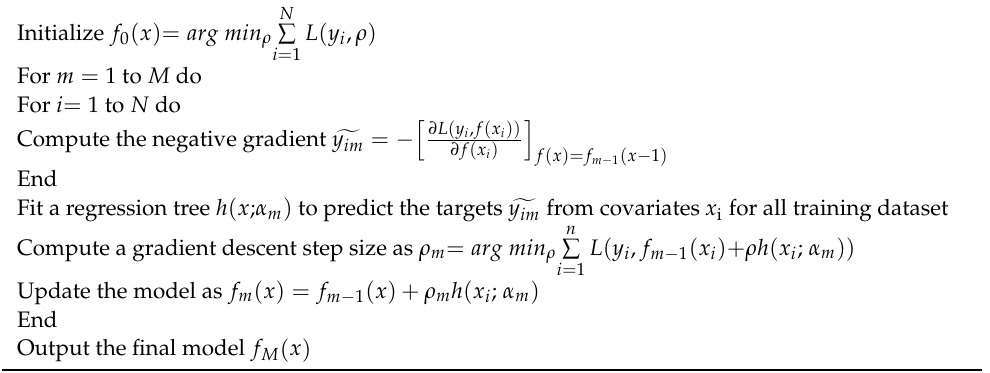
Algorithm A1. The Gradient Boosting Regression Tree